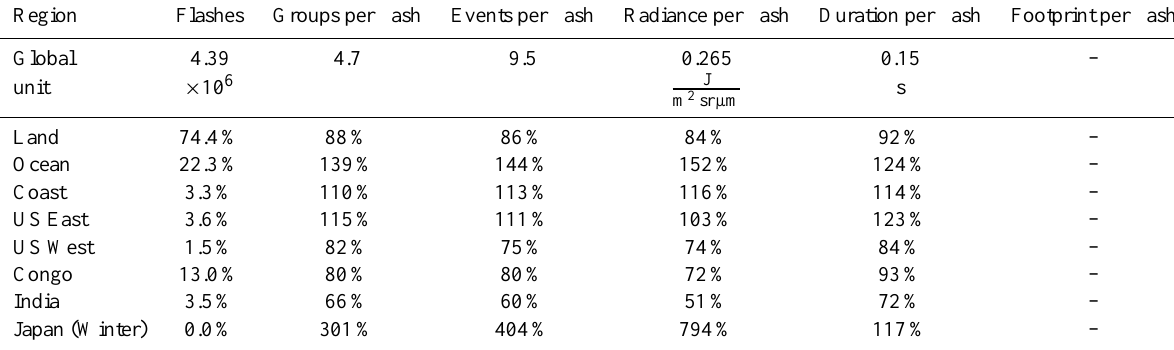
Table 2. Mean OTD flash properties 1995–2000 for different regions. Global values are given in absolute numbers (first row). The following rows are given relative to the global value for better comparison to LIS (Table 3).